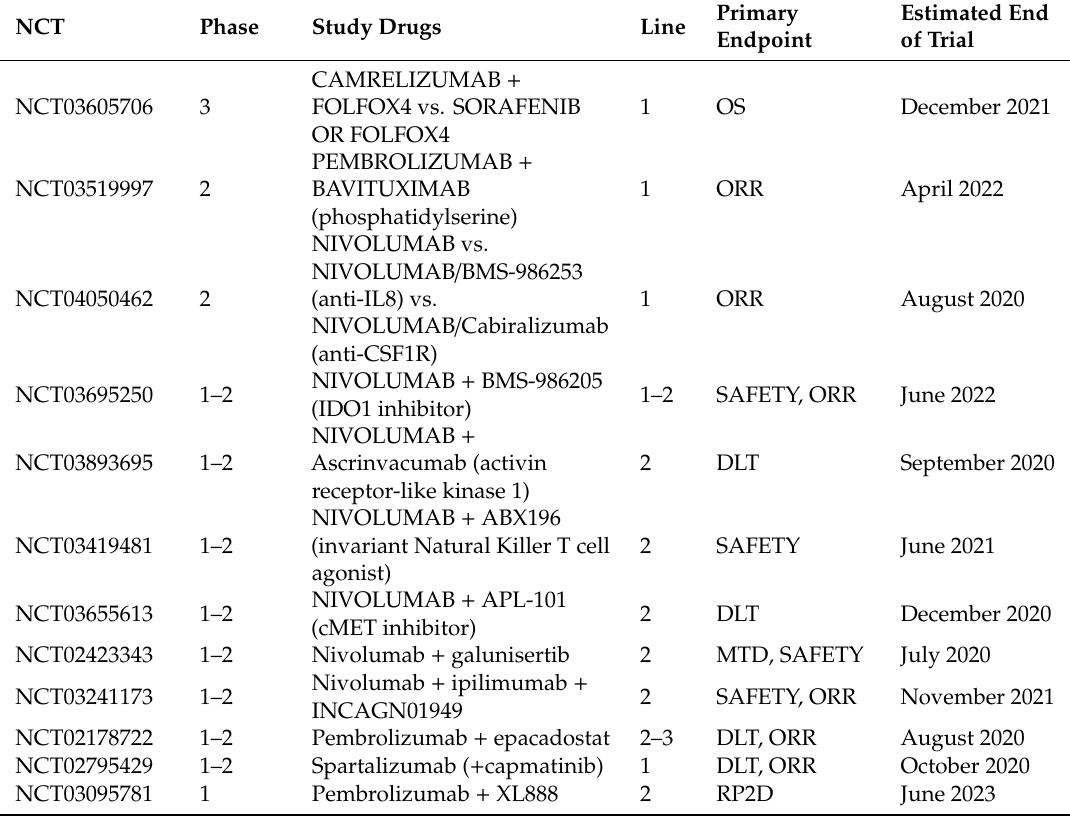
Table 3. Ongoing clinical trials of immune checkpoint inhibitors in combination with di ff erent drugs. NCT Phase Study